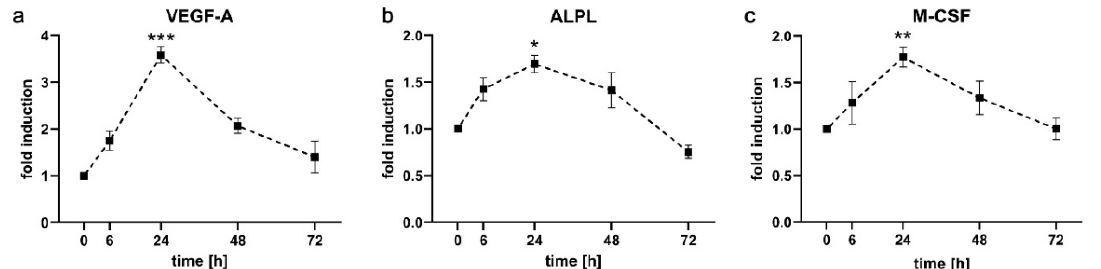
Figure 4. Expression kinetics of genes involved in angiogenesis, osteoblastogenesis and osteoclastogenesis in PDL ‐ hTERT cells under compressive load. Expression of VEGF ‐ A , involved in formation of blood vessels ( a ), ALPL , involved in formation of osteoblasts ( b ) and M ‐ CSF , involved in differentiation of osteoclasts ( c ) at the specified time points was determined via qRT ‐ PCR. Values were referenced to arithmetic means at T = 0 h and are shown as fold over non ‐ treated controls at the respective time points ±SEM. n = 2, n = 6, * 0.01 ≤ p < 0.05, ** 0.001 ≤ p < 0.01, *** 0.0001 ≤ p < 0.01.